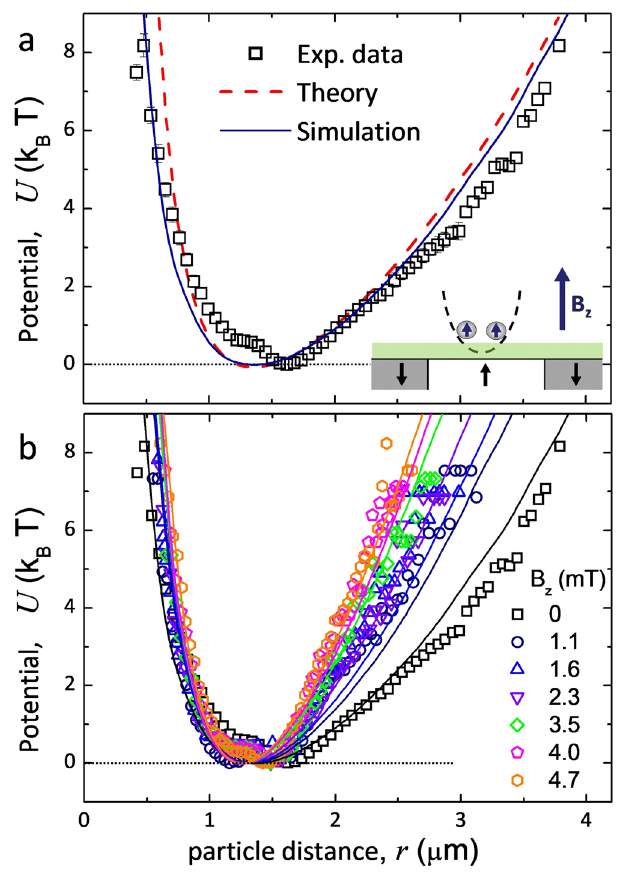
Fig. 3 Total interaction potential. a Total interaction potential U ( r ) between two trapped nanoparticles evaluated from the distribution of the interparticle positions (symbols for experiment and continuous blue line for simulations) and from the formula U ( r ) ≈ 2 U 1 ( r /2) + U 2 ( r ) (theory, red dashed line) versus the interparticle distance r for B z = 0 mT. Small inset shows an image of a pair of con fi ned nanoparticles interacting repulsively due to the parallel induced magnetic moments. b The potential U ( r ) versus r for different amplitudes B z . Symbols and continuous lines refer to the experiment and simulations, respectively. The horizontal dotted line is guide to the eye for U =